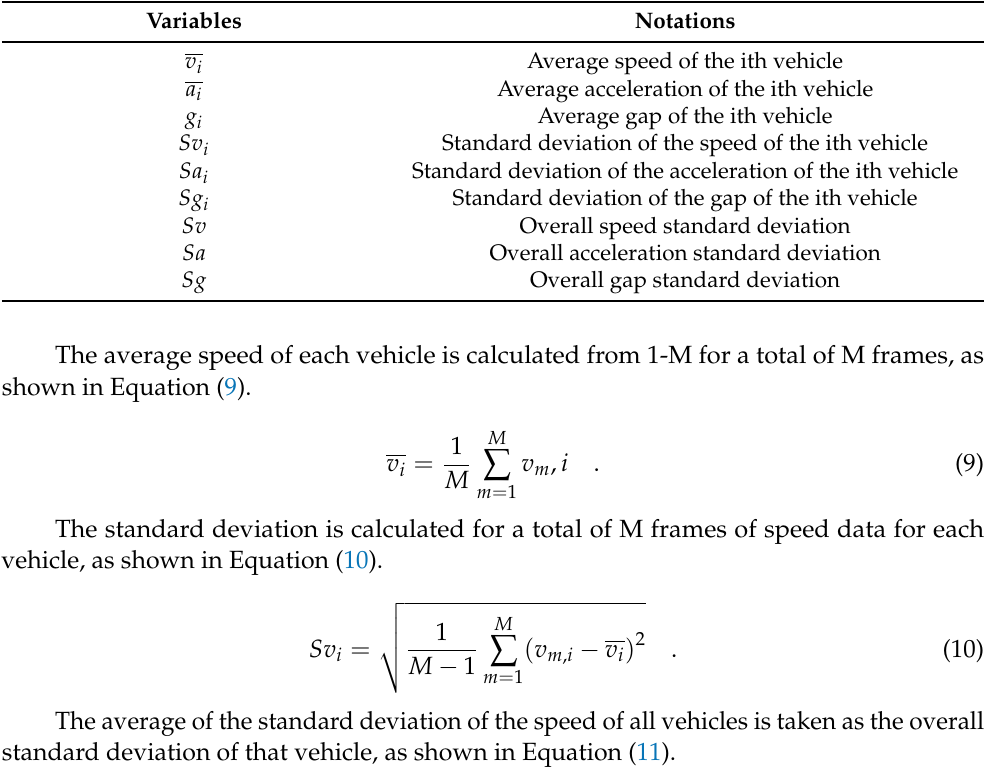
Table 4. Notations of CACC evaluation (2).